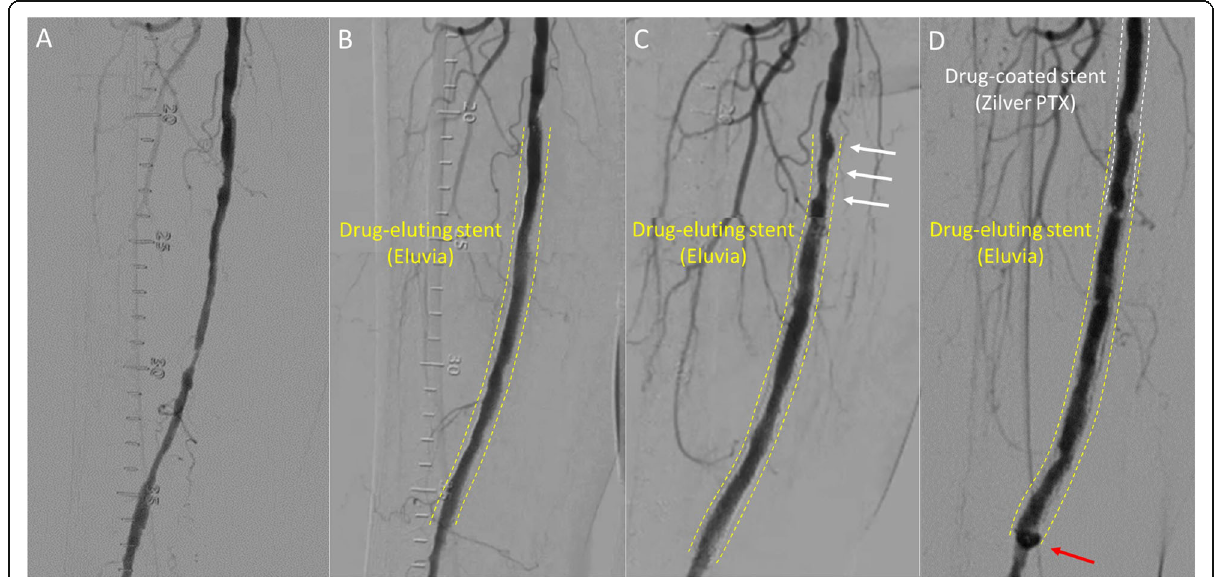
Fig. 1 Conventional angiogram. A : Initial angiography. Initial angiography revealing a severe stenosis from the middle-to-distal part of the right superficial femoral artery. B : Angiography immediately after drug-eluting stent (Eluvia) placement. Angiography showing optimal expansion after drug-eluting stent (Eluvia) placement. C : Angiography 25 months after drug-eluting stent (Eluvia) placement. Angiography revealing proximal in- stent restenosis at the drug-eluting stent (Eluvia) placement site (white arrows). D : Angiography 50 months after drug-eluting stent (Eluvia) placement. Angiography documenting peri-stent contrast staining at the distal part of the drug-eluting stent (Eluvia) placement site (red